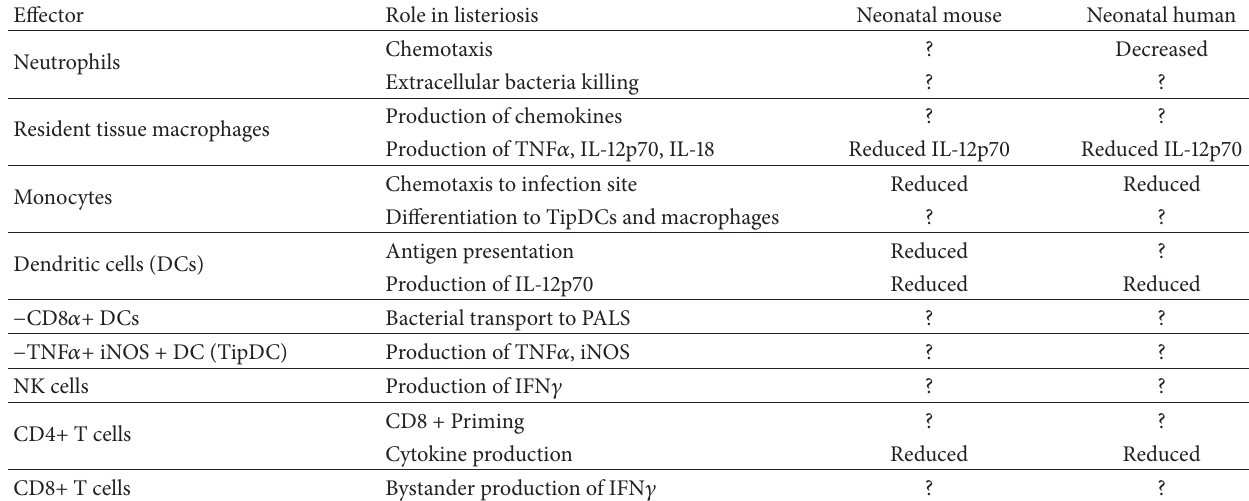
Table 1: Age-dependent differences in systemic immunity to L. monocytogenes .